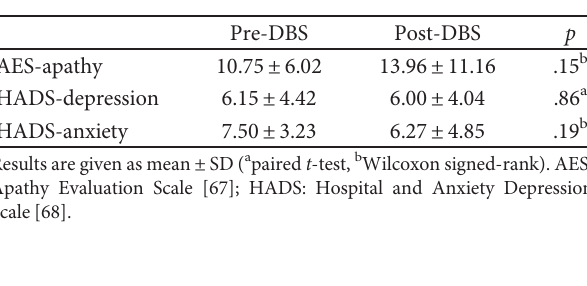
Table 2: Motor symptoms pre- and post-DBS.